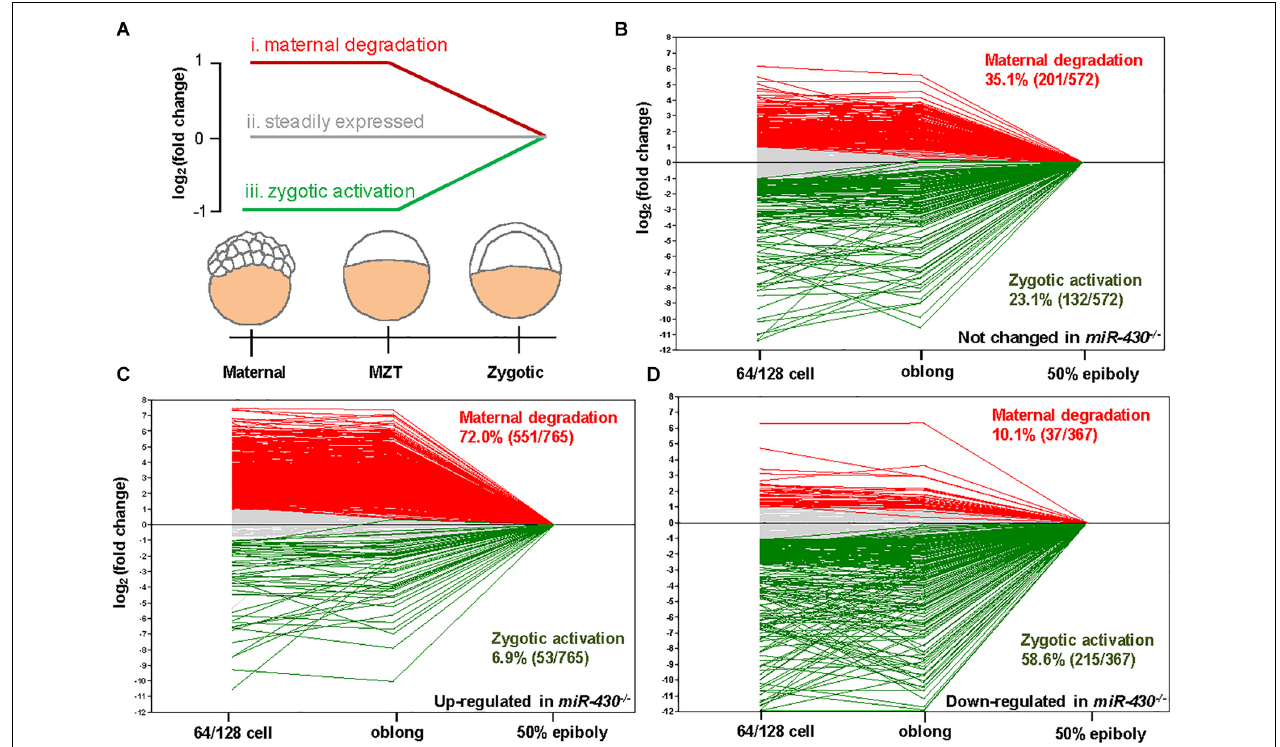
FIGURE 5 | miR-430 is required for the degradation of maternally provided transcripts and activation of zygotic gene expression. (A) Schematic representation of the expression profiles of miR-430 -regulated genes during MZT (64/128-cell stages, oblong and 50 epiboly). The miR-430 -regulated genes were grouped into three categories based on their expression profiles. The expression profiles of genes in the control set (B) , up-regulated set (C) , and down-regulated set (D) of the miR-430 mutants during